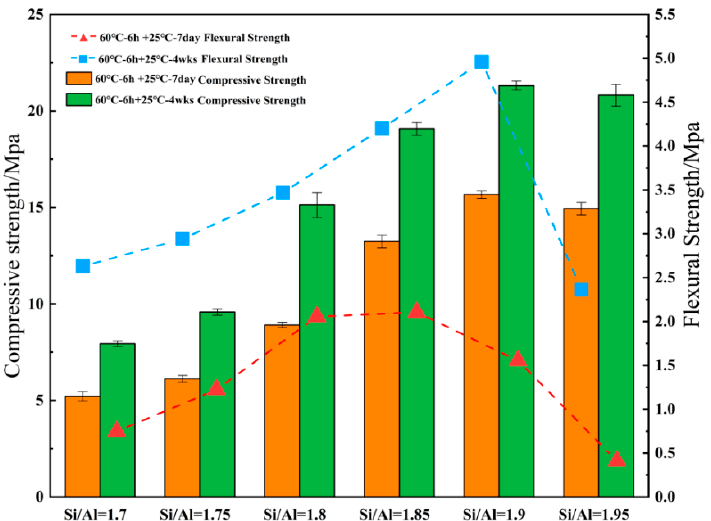
Figure 4. Compressive strength and flexural strength of geopolymer samples with various Si/Al ratios.